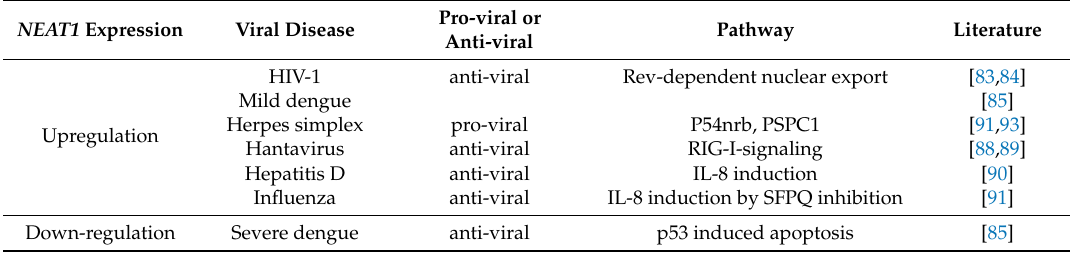
Table 1. NEAT1 expression levels in several viral-induced diseases together with the proposed molecular